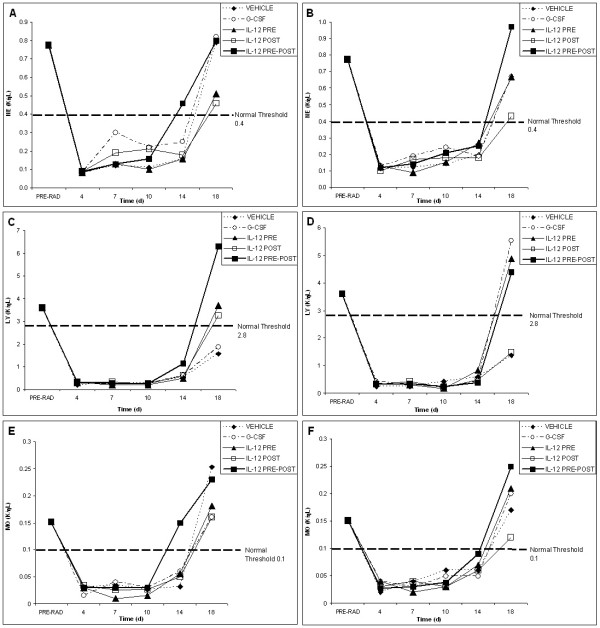
White blood cell recovery profiles for vehicle, G-CSF, IL-12 pre-only, IL-12 post-only and IL-12 pre-post treatment groups following radiation (625 rad). White blood cell recovery profiles are shown for the EL4 tumor model (left; A, C and E) and the Lewis lung cancer model (right; B, D, and F) for neutrophils (A and B), lymphocytes (C and D) and monocytes (E and F). Pre-radiation blood values reflect an average of all animals in both groups (70 mice) before radiation and tumor inoculation. The normal threshold values for neutrophil, lymphocyte and monocyte counts in C57BL/6 mice are indicated. Following the initial dose of vehicle or cytokine, 4 subsequent doses were given every 3–4 days following radiation. IL-12 treated mice received a total dose (5 single doses) of 220 ng, whereas G-CSF treated mice received a total dose (5 single doses) of 5 μg.